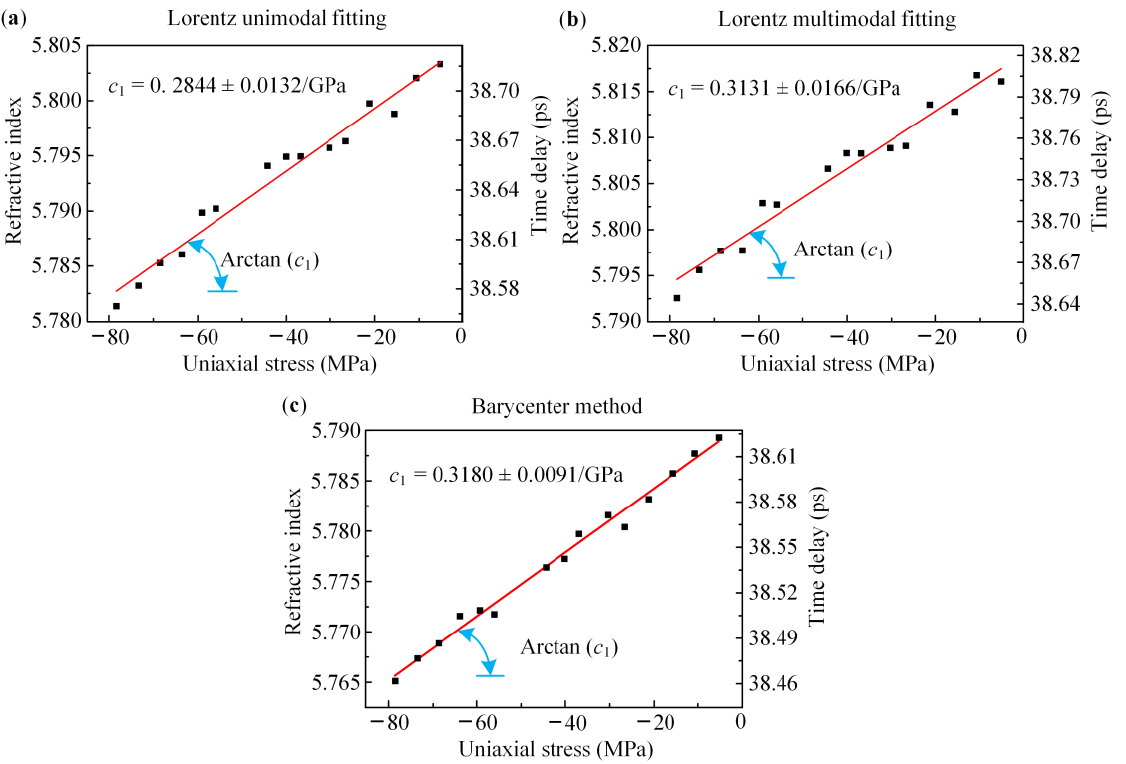
Figure 5. The relation between the refractive index and stress under using different processing methods: ( a ) unimodal fitting method; ( b ) multimodal fitting method; ( c ) barycenter method.